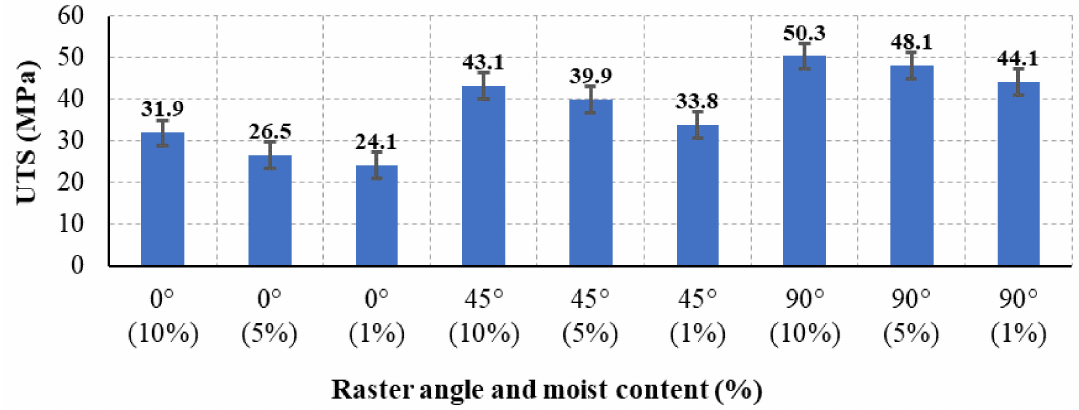
Figure 7. The ultimate tensile strength (UTS) for all specimens with different raster angles and moisture